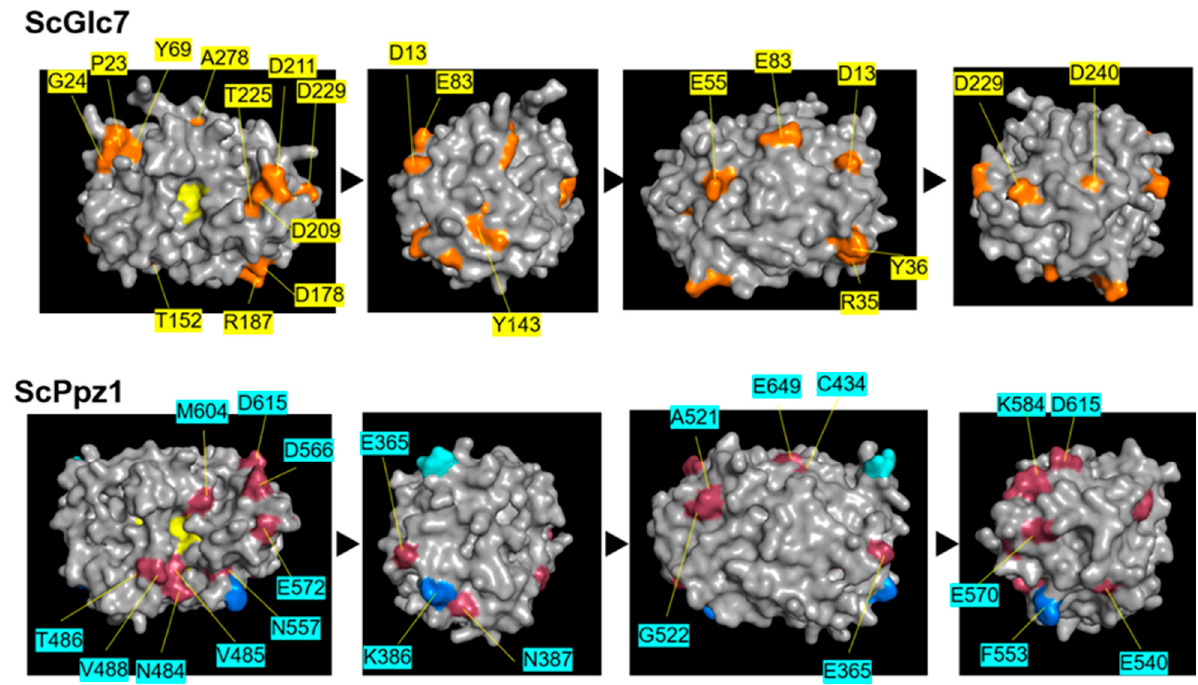
Figure 3. Mapping of relevant surface residues that differ in Ppz1 and Glc7. The upper panel identifies class B residues on the surface of a Glc7 model (orange). In the lower panel, residues in class A (raspberry) or C (blue) are mapped on the surface of the S. cerevisiae Ppz1 model for its catalytic region. Residues forming the catalytic site are shown in yellow. The transition between images corresponds to a rotation (anticlockwise) of 90 ⁰ on the Y -axis.